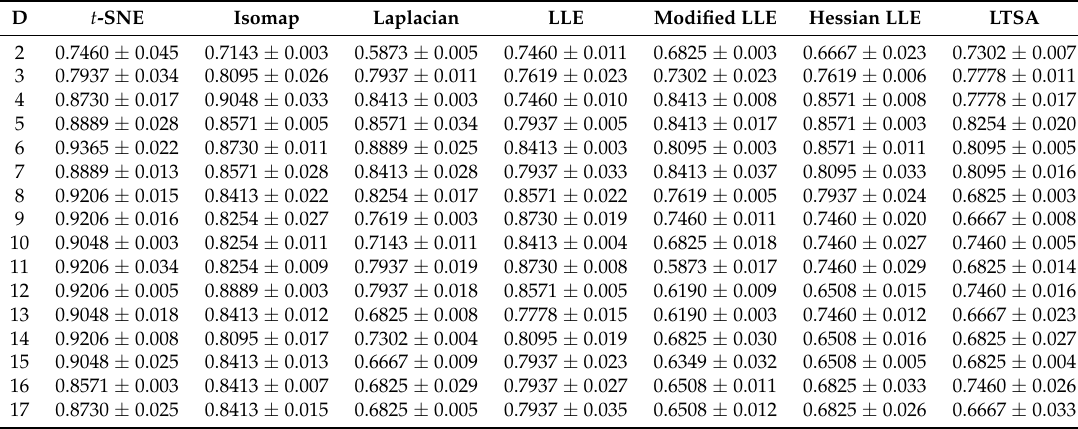
Table 5. Accuracy Average and standard deviation of classification accuracies, values obtained after performing n = 10 experiments. varying the dimensions with respect to the manifold learning algorithms. Data without MCGS applied.